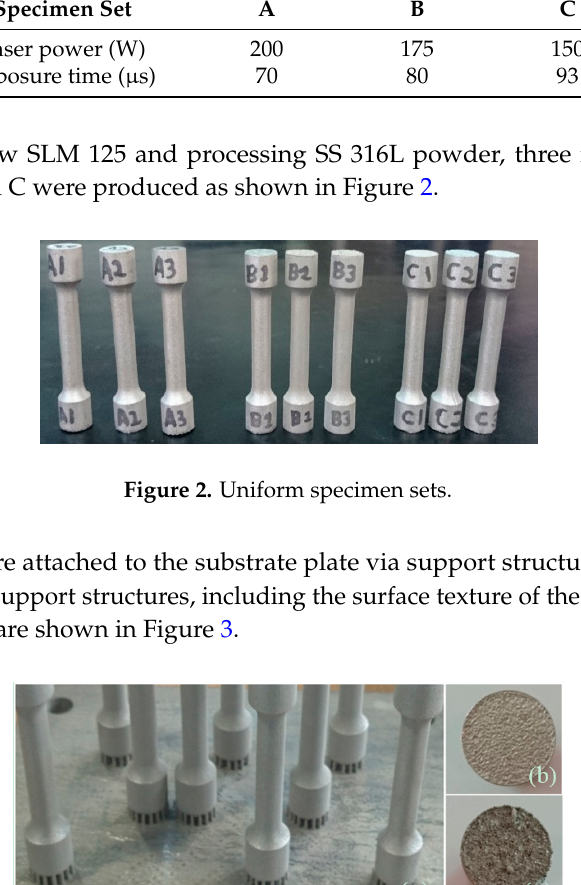
Table 3. Varied parameter range and processing set name/condition.